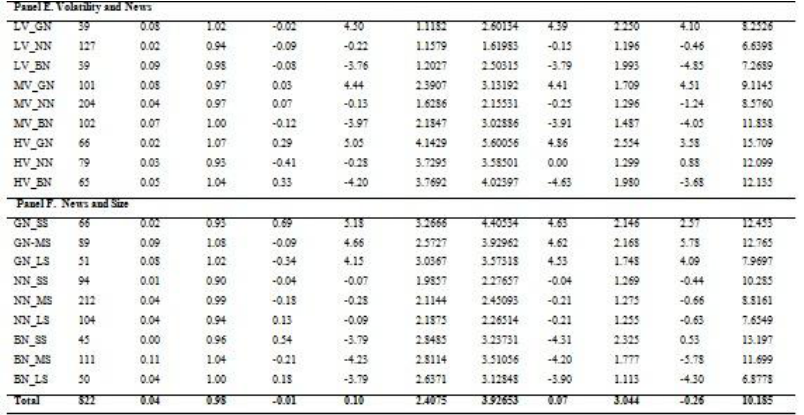
Table 5: Summary Statistics for the 822 quarterly announcements (2)